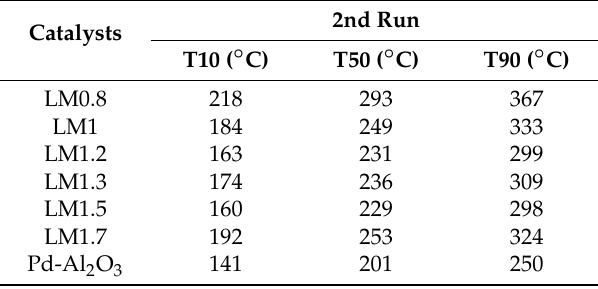
Table 6 lists the temperatures corresponding to 10, 50 and 90% of propene conversion: T10, T50, and T90, respectively. The rank of activity for LM perovskites was similar to that observed for toluene oxidation, namely LM1.5 ~ LM1.2 ~ LM1.3 > LM1 ~ LM1.7 >> LM0.8, with Pd/Al 2 O 3 being the best performing in the entire temperature range. Table 6. Catalytic performance of LM catalysts in comparison with Pd (1 wt %)/Al 2 O 3 in terms of temperatures for achieving 10, 50 and 90% of propene conversion. Data were collected upon